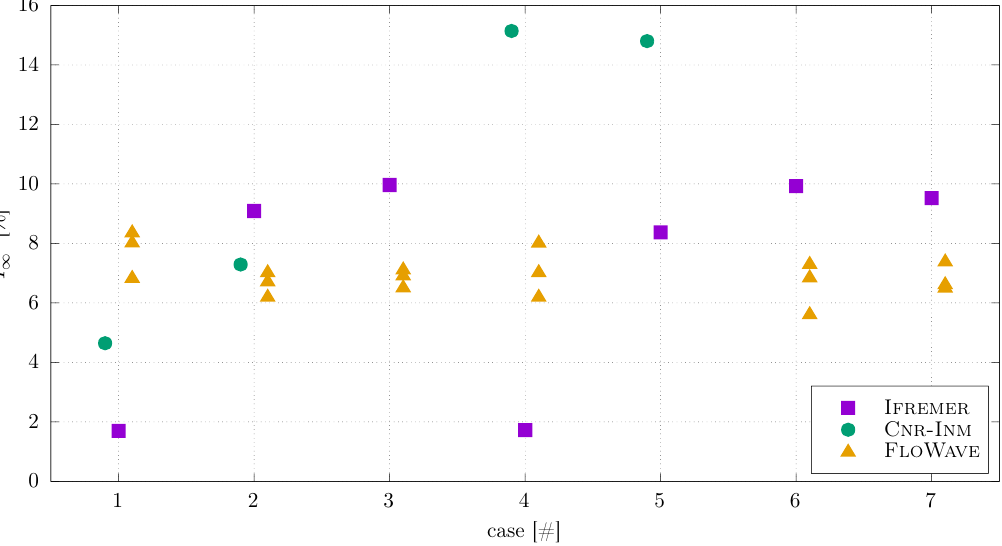
Figure 11. Turbulence intensity I 3 D ∞ processed from the velocity measured with ADV at z = 0 ( P 0 , P 3 and P 4 ) versus case numbers. For the wave and current tests, the wave frequency component has been filtered and removed from the velocity